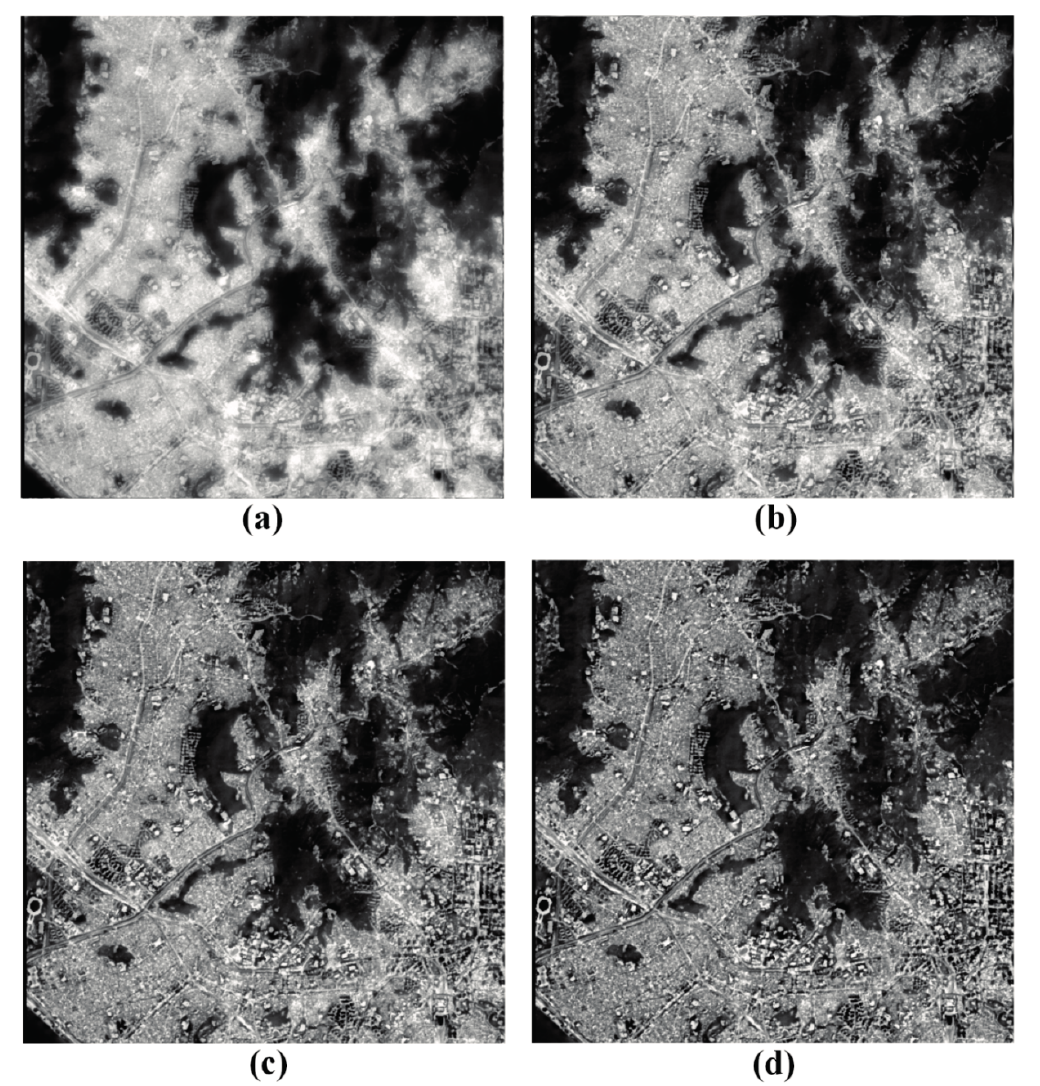
Figure 3. The fused images from the PAN and TIR images of Figure 2a,b by using